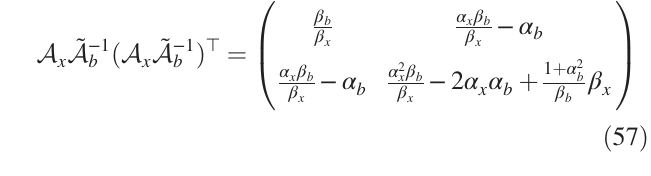
FIG. 5. The horizontal and vertical beam positions function of the number of turns for a beam with initial emittance ratio ε rotated by η ¼ 30 °. The initial mismatch decoheres, and the emittance reaches its asymptotic value, given by Eq.